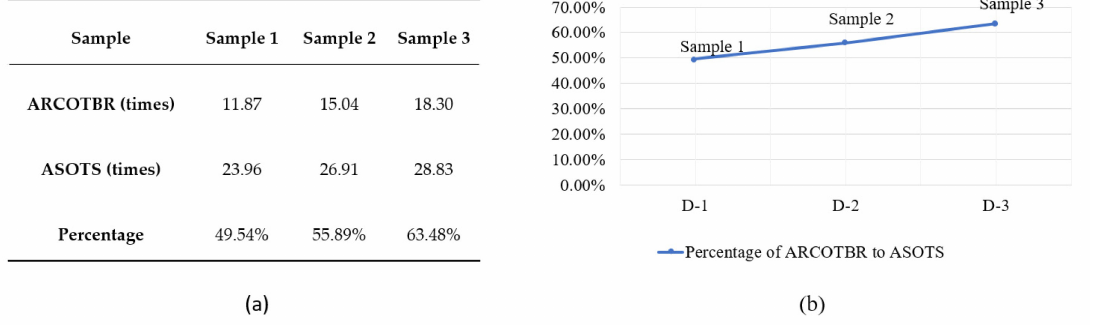
Figure 8. Analysis of fixation trajectory in experiment 1: ( a ) Relevant data for fixation trajectory in Experiment 1 and ( b ) relationship between the percentage of ARCOTBR to ASOTS, and the distribution of building blocks (the experiment 1).